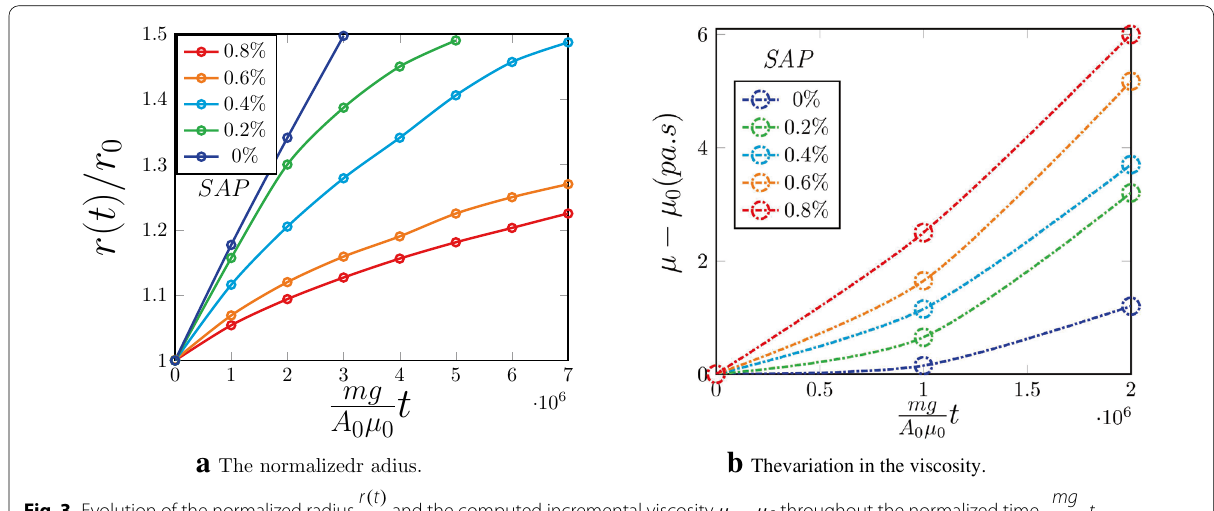
Fig. 3 Evolution of the normalized radius